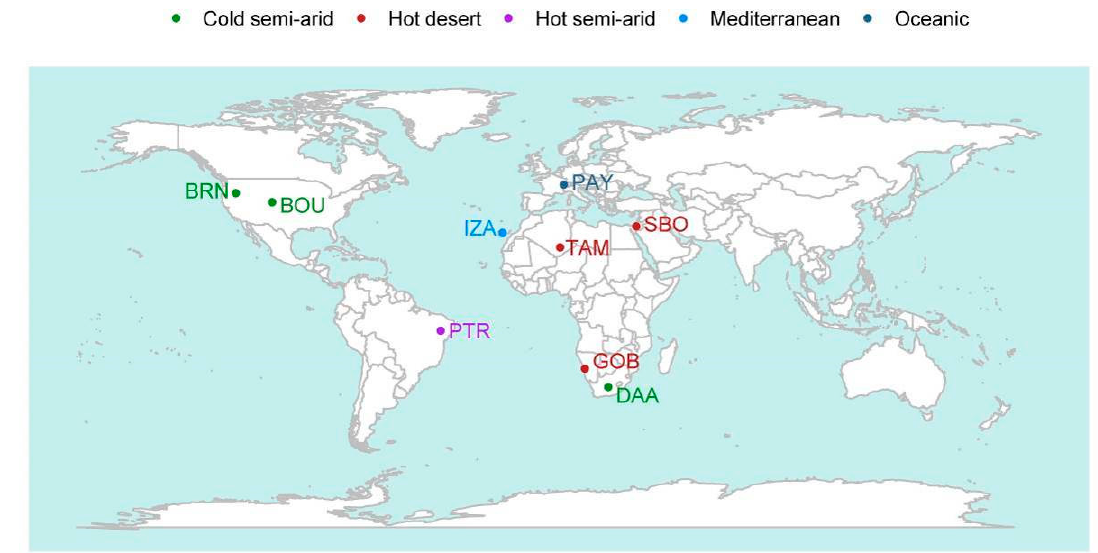
Figure 1. Measurement sites selected for this study, with a color code showing the climate zone to which each one belongs.